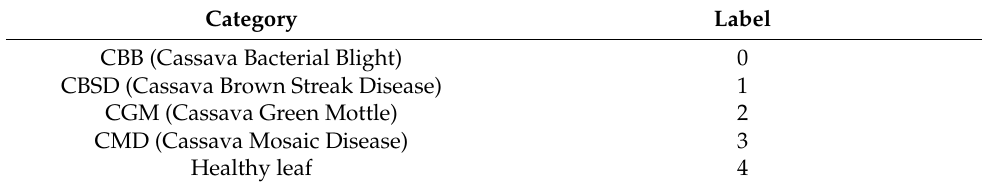
Figure 4. Images of healthy and unhealthy cassava mosaic diseases. ( a ) CBB, ( b ) CBSD, ( c ) CGM, ( d ) CMD, ( e ) healthy. Dataset URL: https://www.kaggle.com/c/cassava-leaf-disease-classification/ data (accessed on 1 June 2022). Table 1. Correspondence between disease categories and